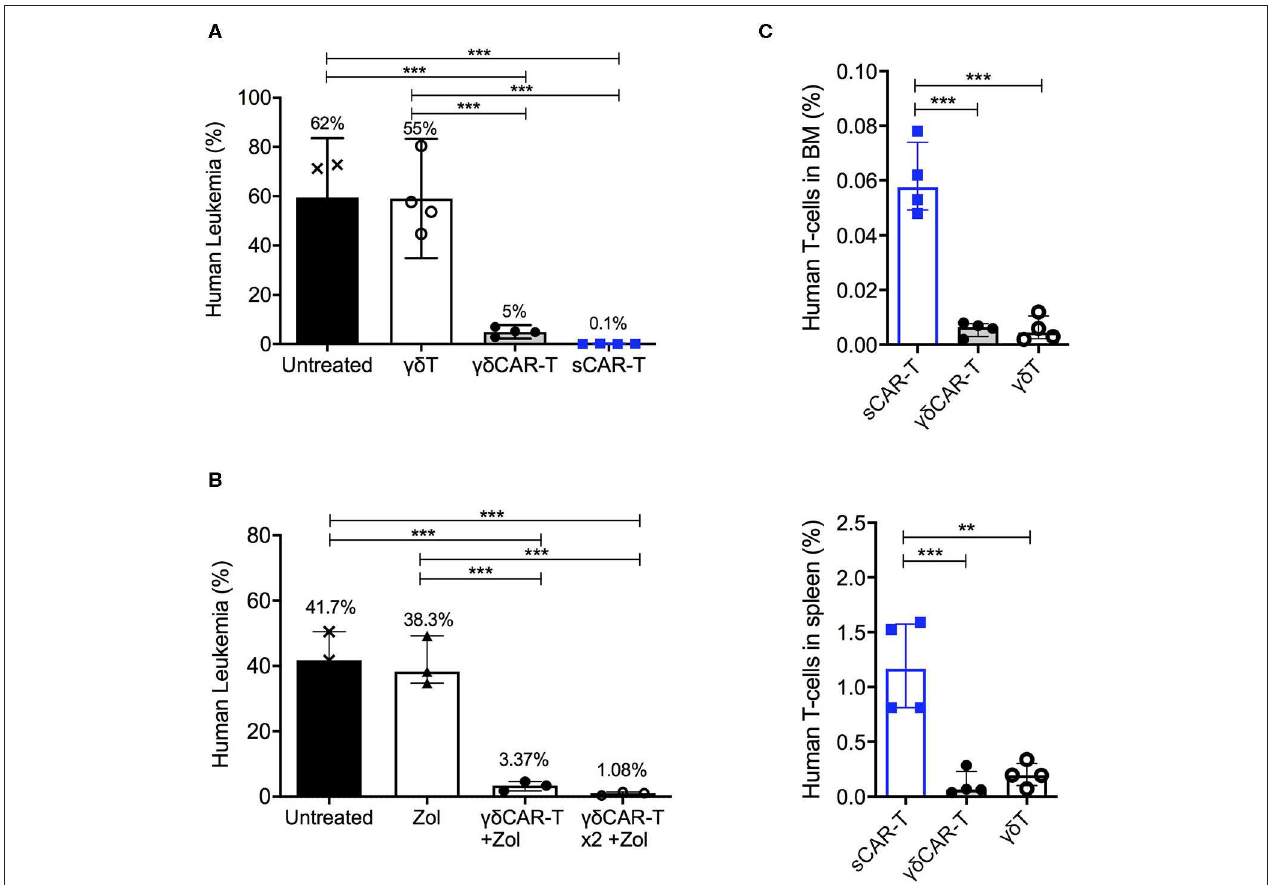
FIGURE 4 | In vivo activity of γδ CAR-T cells. (A) Human leukemia (Nalm6) gated on CD45 + CD10 + in the bone marrow of NSG-mice either untreated or treated with un-transduced γδ T cells, γδ CAR-T, or sCAR-T cells after 14 days. (B) Human leukemia (Nalm6) gated on CD45 + CD10 + in the bone marrow of NSG-mice either untreated or treated with zoledronate (Zol) alone, Zol with γδ CART cells, or repeated dose of Zol and γδ CAR-T. (C) Human effector cell persistence of.i.v. injected sCAR-T, γδ CAR-T, and un-transduced γδ -T cells in mice bone marrow (upper panel) and spleen (lower panel), 3 days post injection. ** P ≤ 0.01, *** P ≤ 0.001, Two tailed paired T -test. Bars are at the median value, and error bars represent interquartile